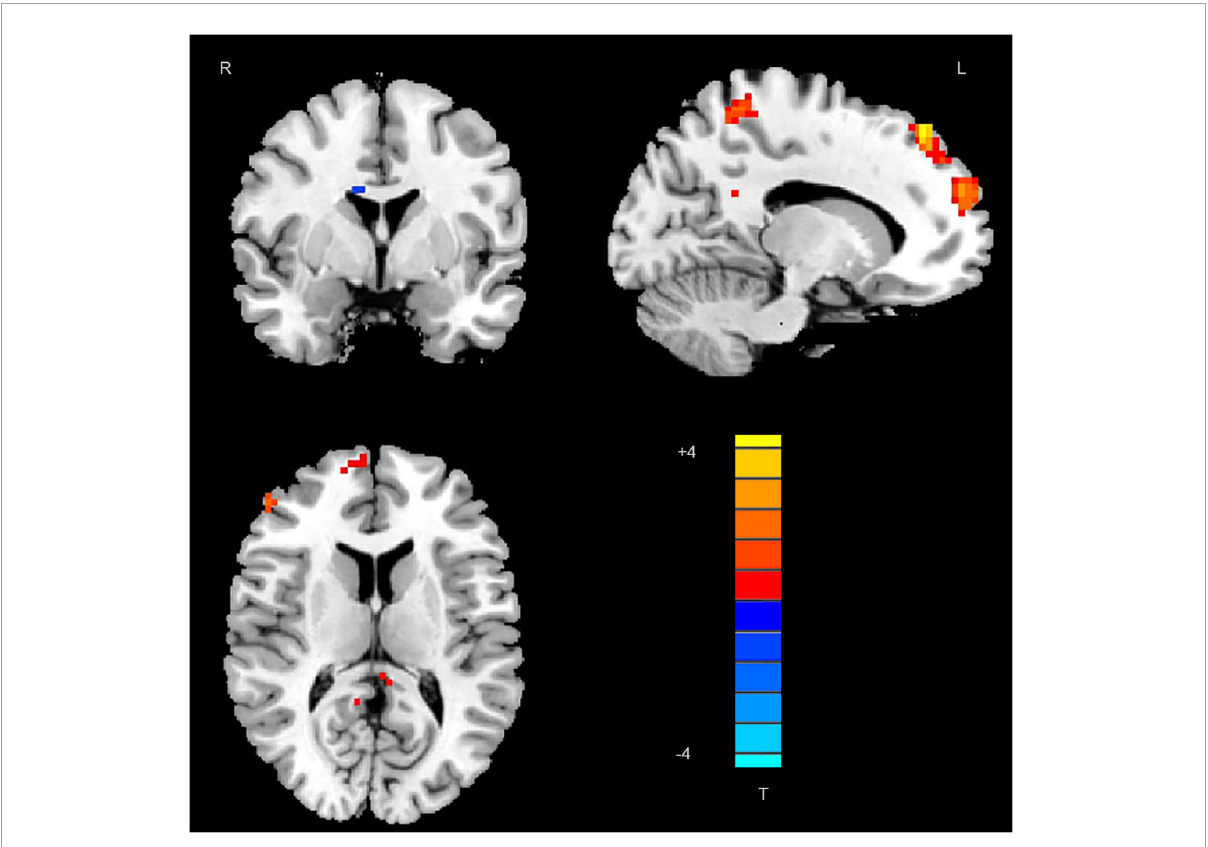
FIGURE1 Decreased DC values in the right caudate and increased DC values in the left middle temporal gyrus, superior parietal gyrus, superior frontal gyrus, right precuneus, frontal gyrus Inferior gyrus, middle-superior frontal gyrus, and inferior parietal gyrus in patients. DC, degree centrality; MTG, middle temporal gyrus; SPG, superior parietal gyrus; SFG, superior frontal gyrus; PCu, precuneus; IFG, frontal gyrus Inferior gyrus; MSFG, middle-superior frontal gyrus; and IPG, inferior parietal